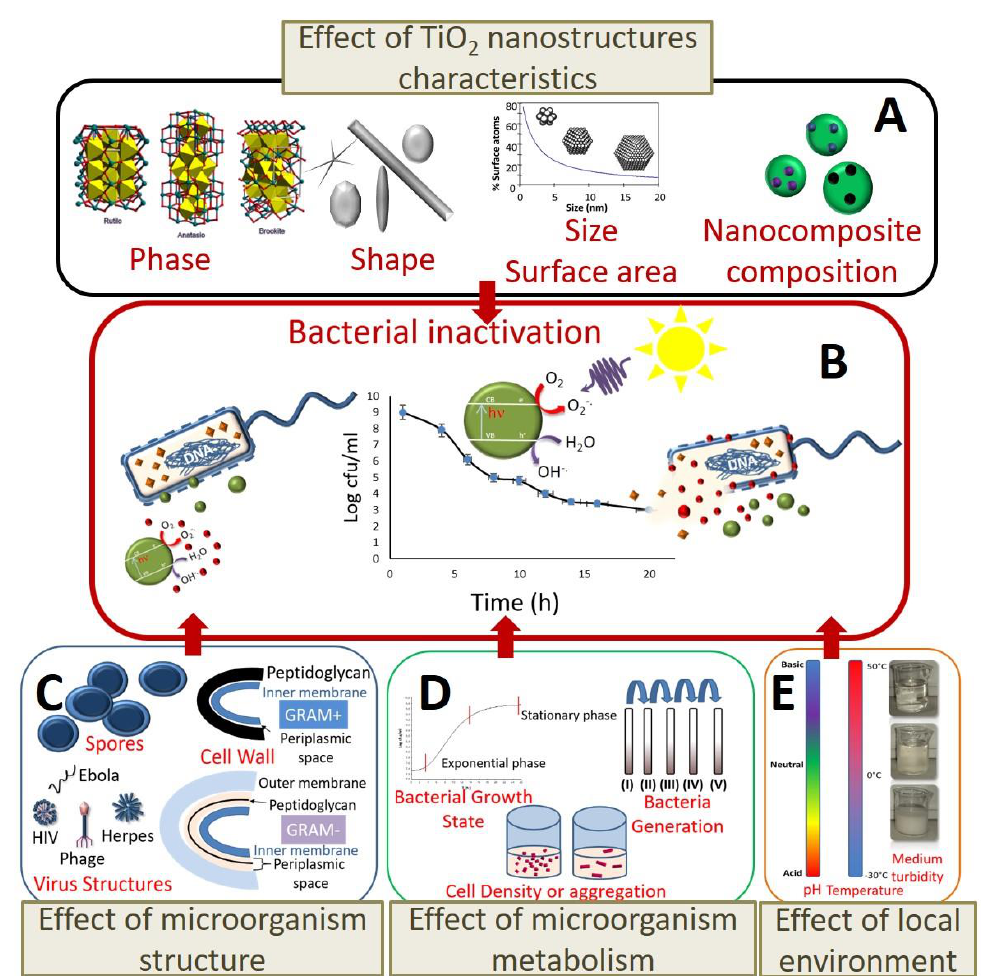
Figure 8. E ff ect of factors influencing the photocatalytic action of TiO 2 NPs and TiO 2 -based nanocomposites on bacterial and viral inactivation: ( A ) crystalline phase, NP size, and surface area and composition of the nanocomposite a ff ect the photocatalytic e ffi ciency; ( C ) microorganism structure, ( D ) its metabolism, and ( E ) local environment adopted for its growth strongly a ff ect the response of the microorganism to photocatalytic inactivation ( B